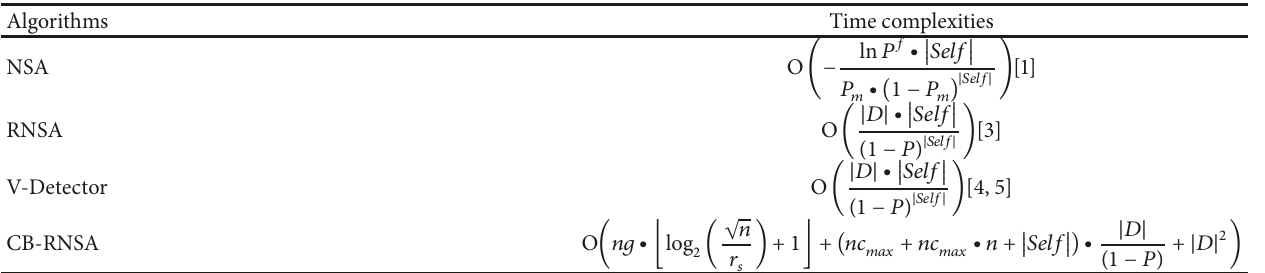
Table 1: Contrast of time